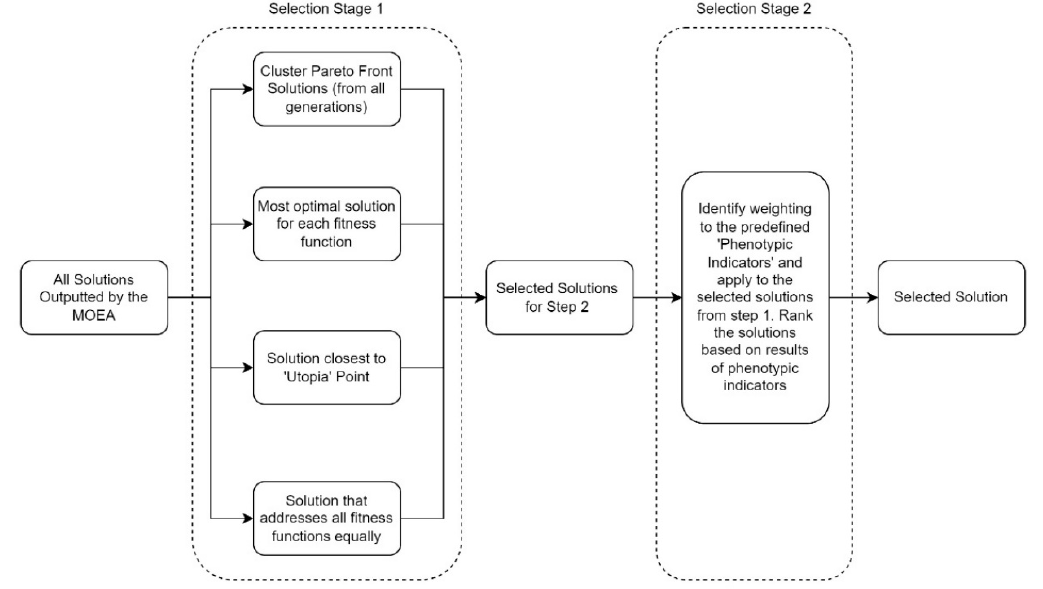
Figure 1. Pseudo code of both stages of the selection framework.